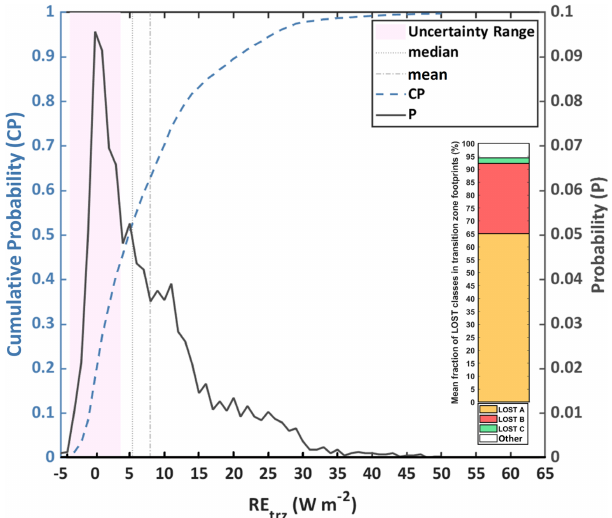
Figure 3. Empirical cumulative (left axis) and absolute (right axis) probability distributions of the RE trz calculated for the 3783 transition-zone footprints selected in the southeastern Atlantic Ocean during August 2010. In this figure, the RE trz bins are 1Wm − 2 wide and centered at each whole number. The area colored in pink shows the uncertainty range, which was obtained through validating the π ↑ L RTM , clr against π ↑ L CERES , clr (for more in- formation refer to Fig. 2a). The bar chart shows the mean fraction of the “Lost” classes in the transition-zone footprints analyzed. The white area named as “Other” in the bar chart represents the mean fraction of the classes “Difficult”, “Cloud”, “Aerosol”, and “Clear” combined. (Note that the sum of all fractions given in the bar chart equals